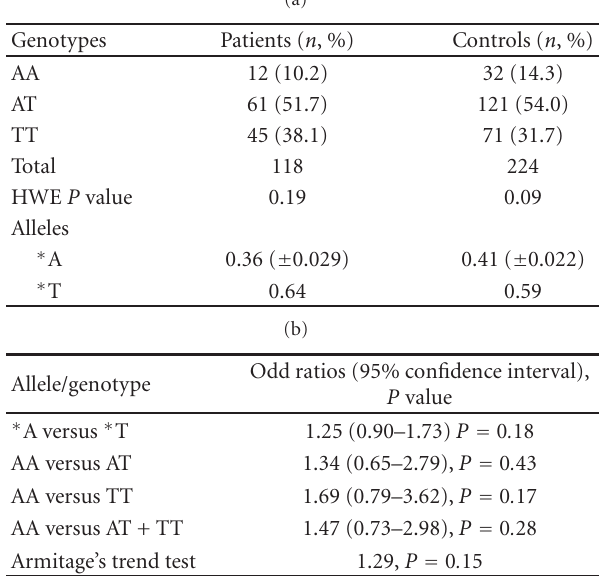
Table 2: The distribution of BMP2 SNP3 genotype and allele fre- quencies and odds